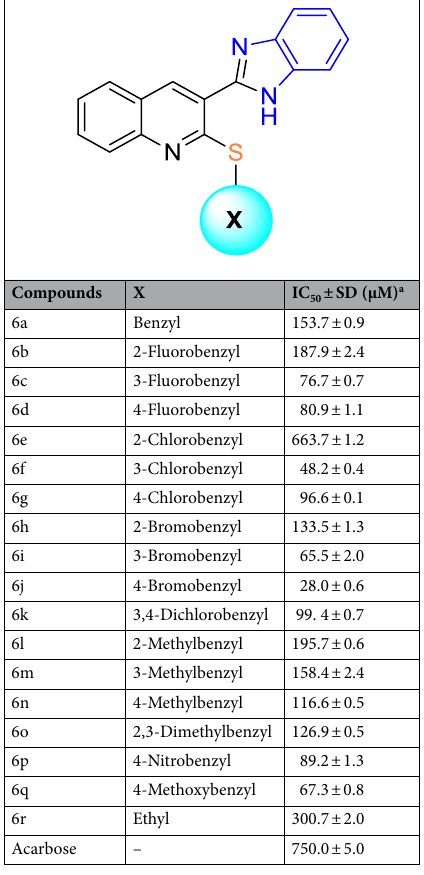
Table 1. α-glucosidase inhibitory activity of 6a–r a Data represented in terms of mean ± SD.